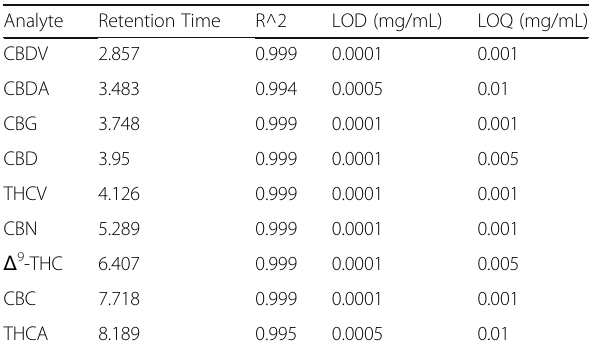
Table 1 Specificity Data Analyte Retention Time